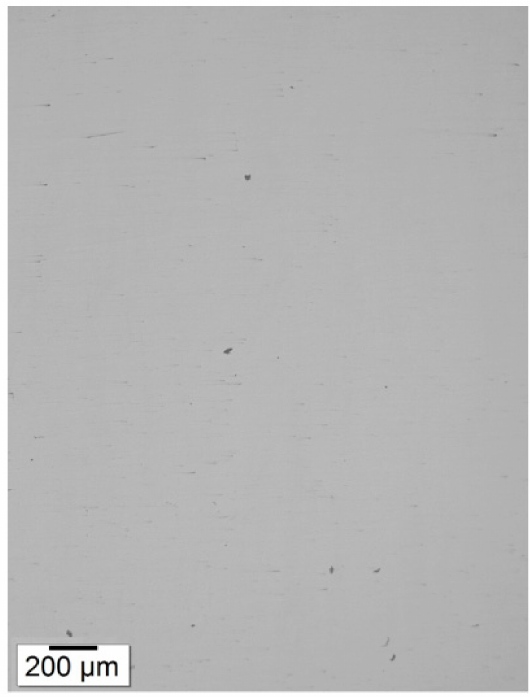
Figure 6. IN713LC sample fabricated using low energy density of 170